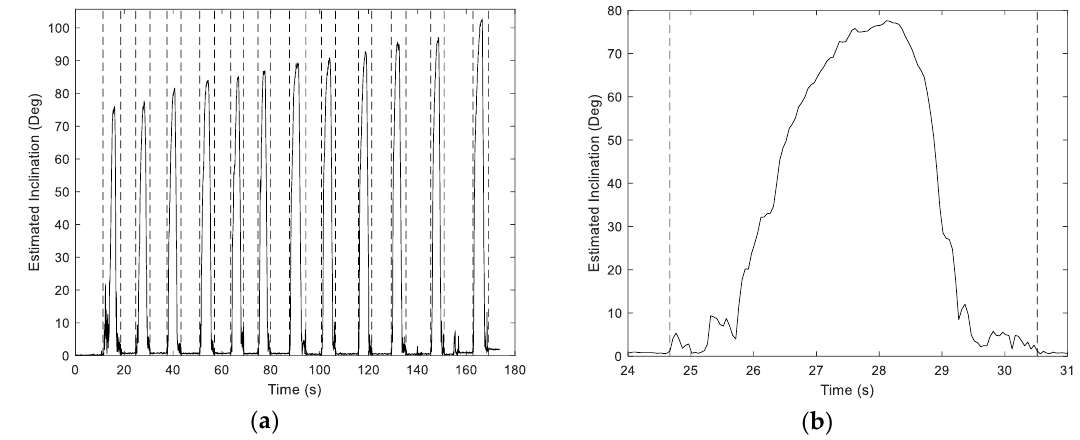
Figure 4. ( a ) Variation in estimated container inclination over an experimental trial (wide view); ( b ) zoom view for drink 2.